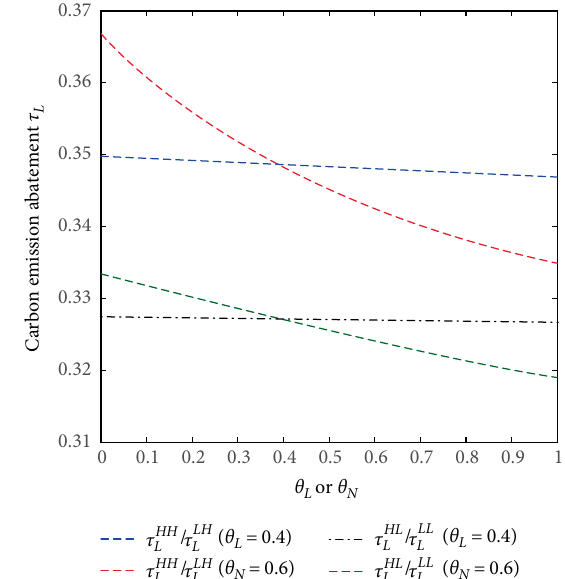
Figure 2: Impacts 𝑠 of on Π . Figure 3: Relationship between 𝜏 𝐿 and 𝜃 𝑖 .